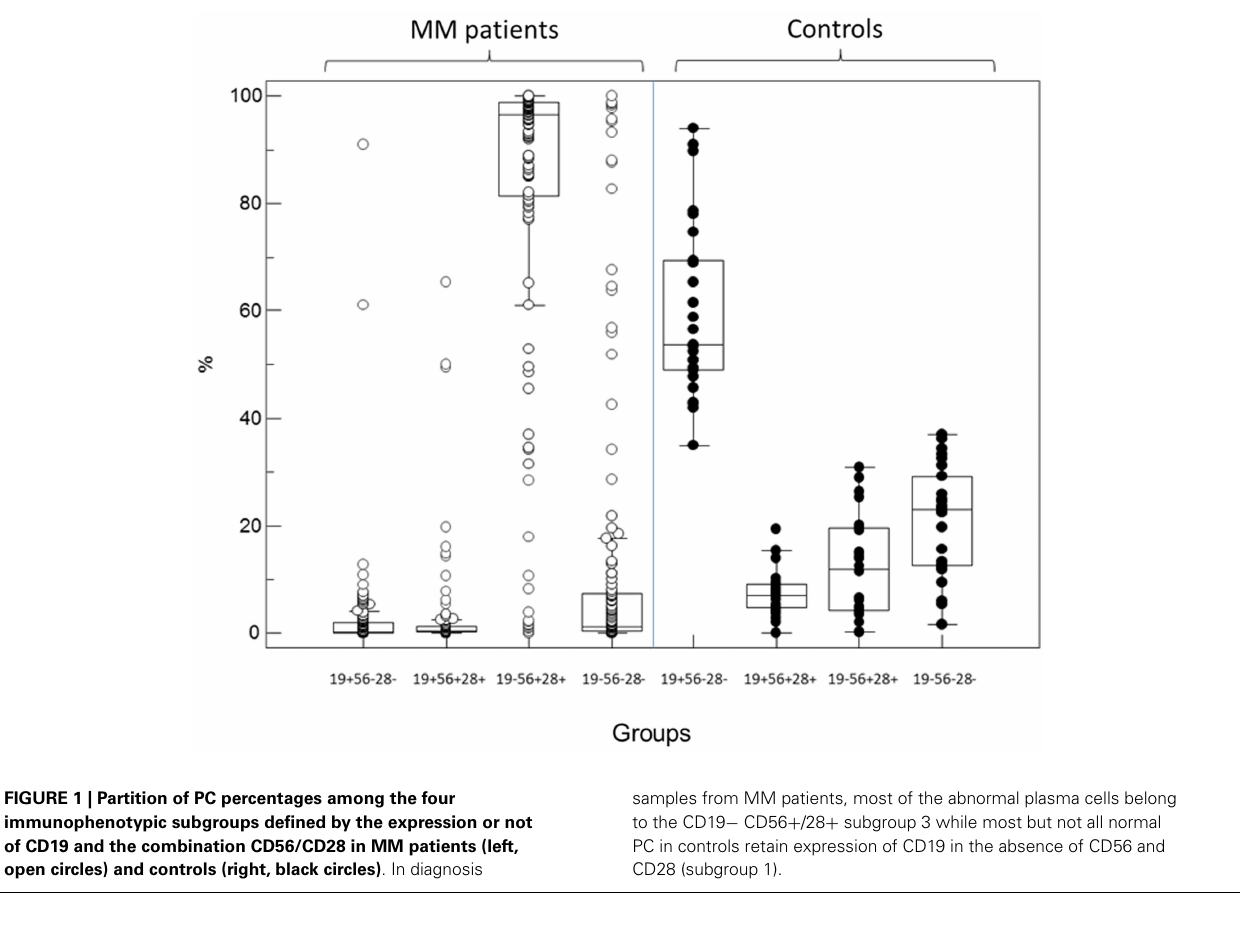
FIGURE 1 | Partition of PC percentages among the four immunophenotypic subgroups defined by the expression or not of CD19 and the combination CD56/CD28 in MM patients (left, open circles) and controls (right, black circles) . In diagnosis